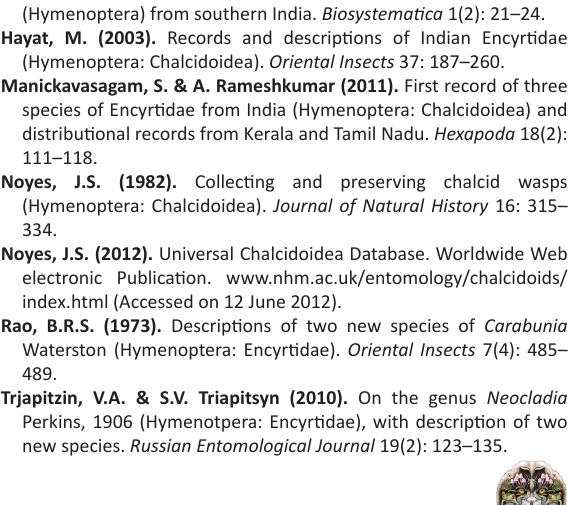
and silvery white